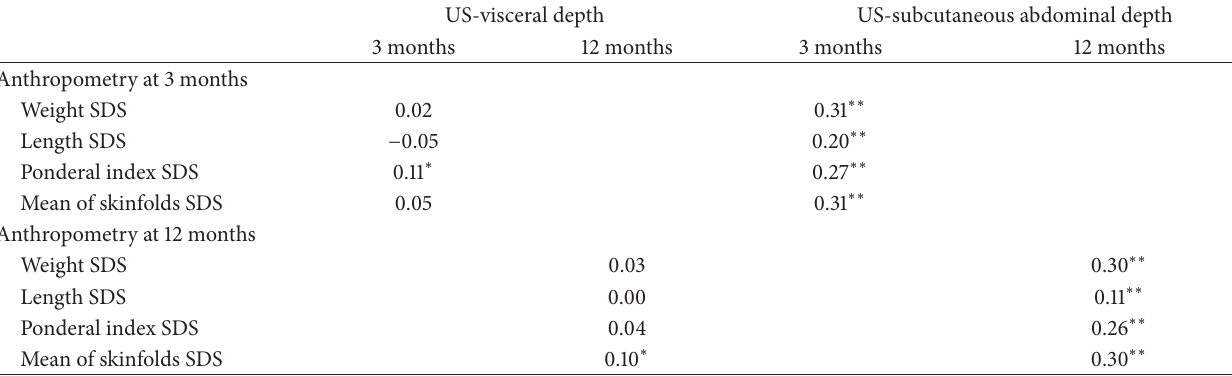
Table 5: Cross-sectional correlations between anthropometry 1 and abdominal ultrasound measures at 3 months (487 infants) and 12 months (495 infants). Data are Pearson’s coefficients.